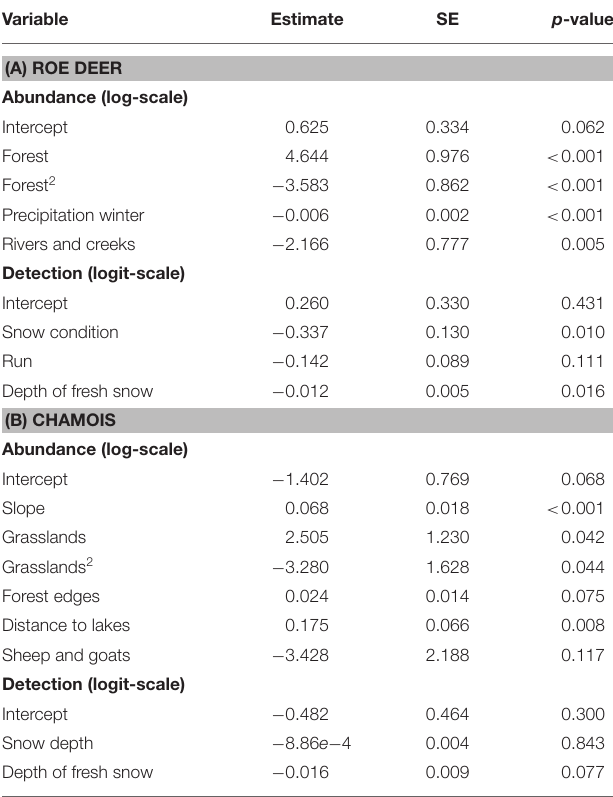
TABLE 4 | The best N-mixture models for predicting relative densities of roe deer (A) and chamois (B). Variable Estimate SE p